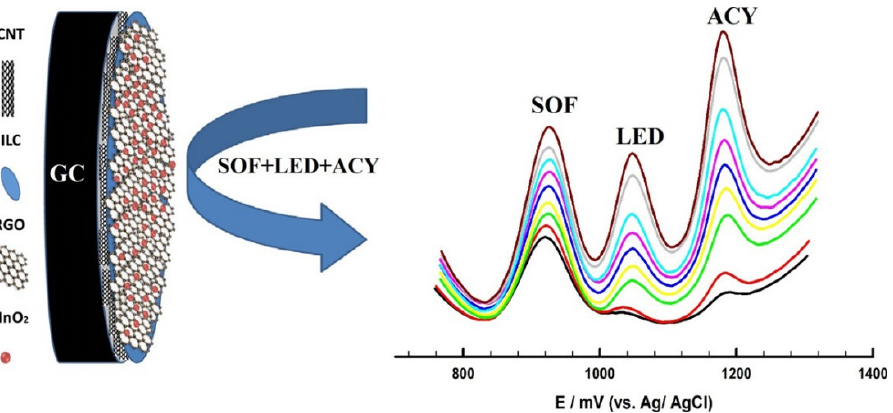
Figure 5. General scheme of GCE/CNT/ILC/RGO/MnO 2 sensor development and electroanalytical signal related to the simultaneous oxidation of antiviral drugs sofosbuvir (SOF), ledipasvir (LED), and acyclovir (ACY) (reproduced from Atta et al. [96] , with permission from Elsevier, 2014).